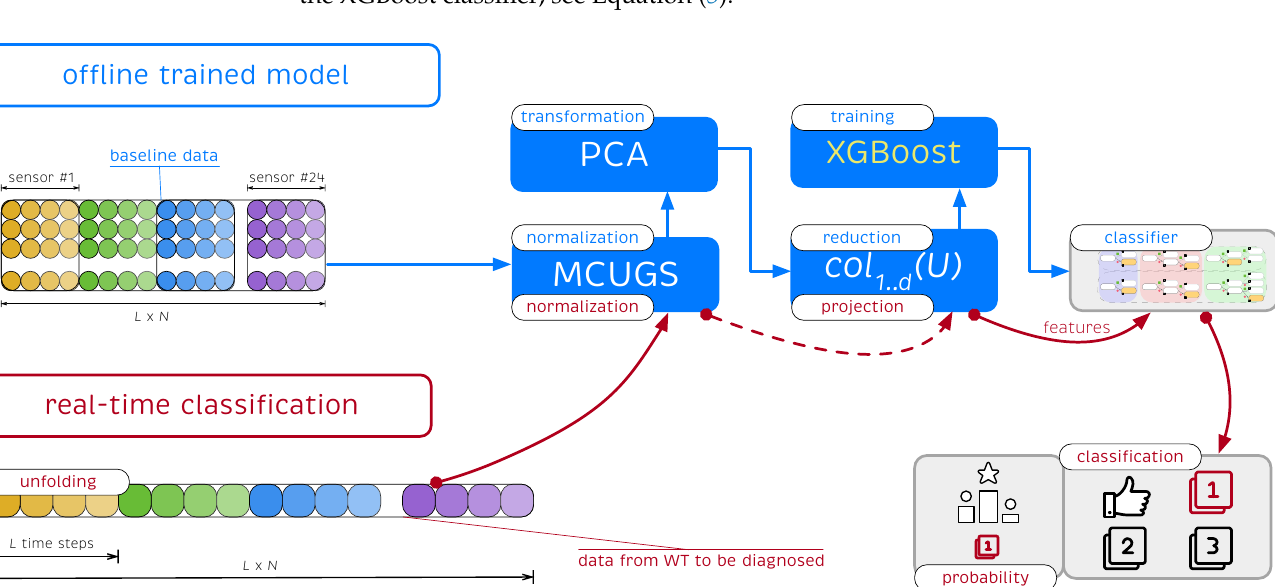
Figure 7. Flowchart of the proposed methodology of real-time structural damage diagnosis to classify a new wind turbine (WT). Data from a structure were first normalized and then projected into the PCA model. Finally, XGBoost is applied to obtain a class prediction and probability of class